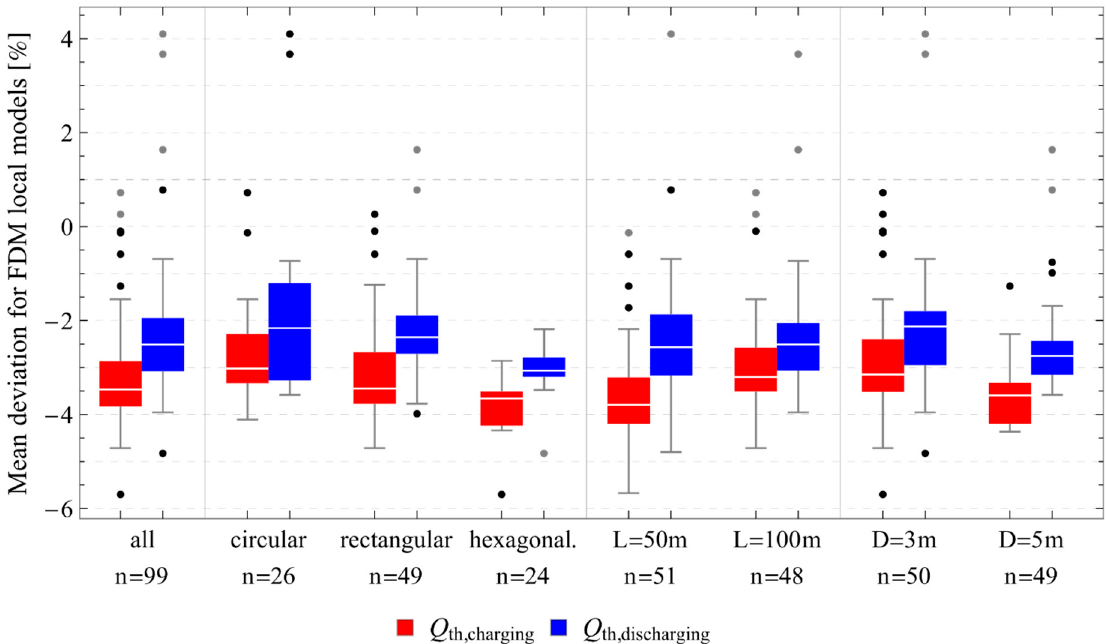
Figure 7. Impact of different parameters on the deviation of charged and discharged energy between FEFLOW and MoBTES models using an FDM local model (L = BHE length, D = minimal BHE distance).